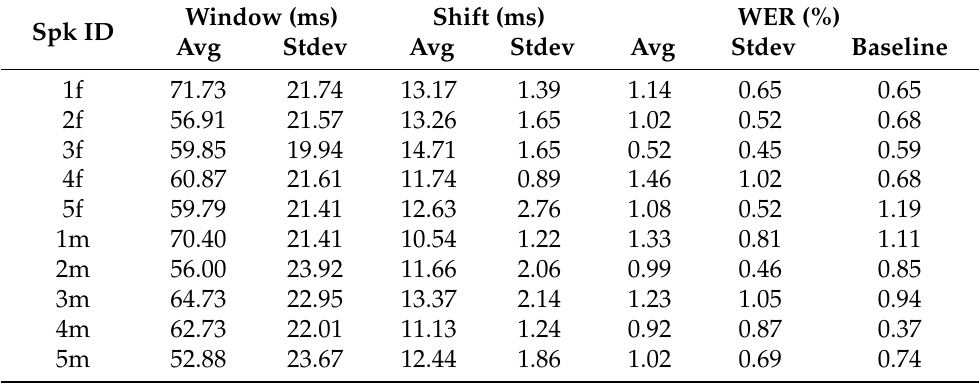
Table 3. Experiment results with CLIPS database: speakers’ Optimal Regions and their WER compared with baseline (window and shift respectively 25 and 10